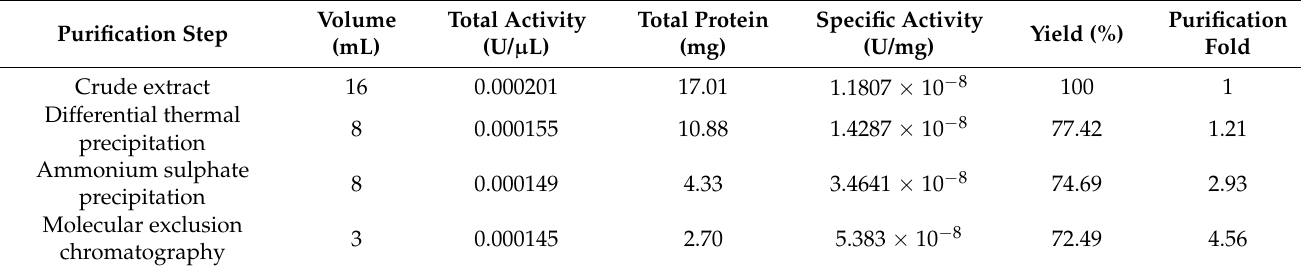
Figure 4. SDS-PAGE of the purification steps for LipB12_A11. (M) NZYColour Protein Marker II (NZYTech, Portugal), (1) crude extract, (2) supernatant after thermal treatment (60 °C, 20 min), (3) pellet from 30% ammonium sulphate precipitation, (4) pellet from 50% ammonium sulphate precipitation, (5) dialyzed and concentrated fraction, (6) pooled molecular exclusion fractions showing lipolytic activity, (7) supernatant from the 50% ammonium sulphate precipitation, (8) concentration column flow-through. Black arrows represent the LipB12_A11 enzyme migration band. Table 2. Purification steps for LipB12_A11.